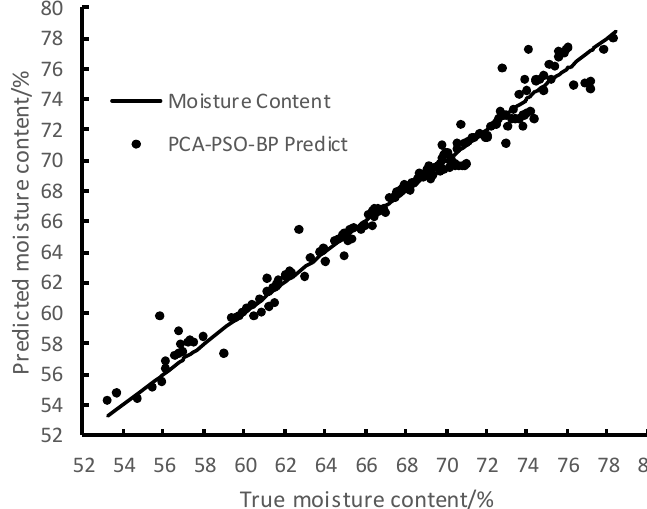
Figure 10. LDA-PSO-BP model prediction scatter plot.